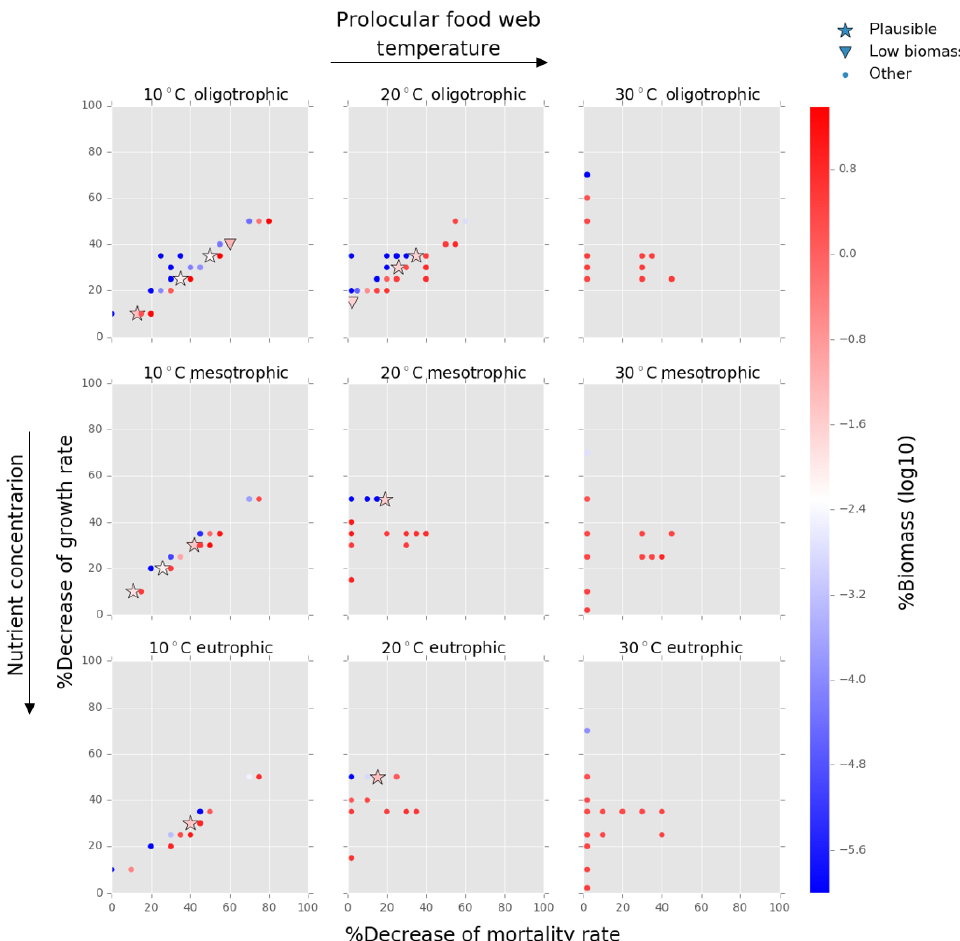
Figure 6. Results from the food web model for the calcification cost (reduction of growth) and benefit (reduction of mortality rate) for the prolocular life stage of planktonic foraminifera. Legend shows other for total tested simulations, low biomass for simulations for which their biomass is within the defined range and plausible for the simulations we consider to be as most likely. More details on low biomass and plausible simulations are given in Sect. 2.3, “Adding planktonic foraminifera to the model”. For the meso- and eutrophic environments of 20 ◦ C and all environments of 30 ◦ C, the pattern of the simulations is more scattered than for the remaining environments. This is because in a range of a 0% to 50% reduction on the mortality rate, the relative biomass of planktonic foraminifera was high and outside the observation range. As a further reduction of the mortality rate would result in an additional increase of relative biomass, the sensitivity analysis was not